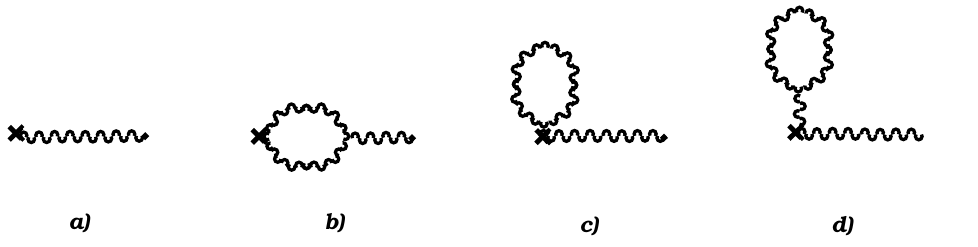
Figure 2 . One-loop diagrams for q/b 2 in T (eff) zz